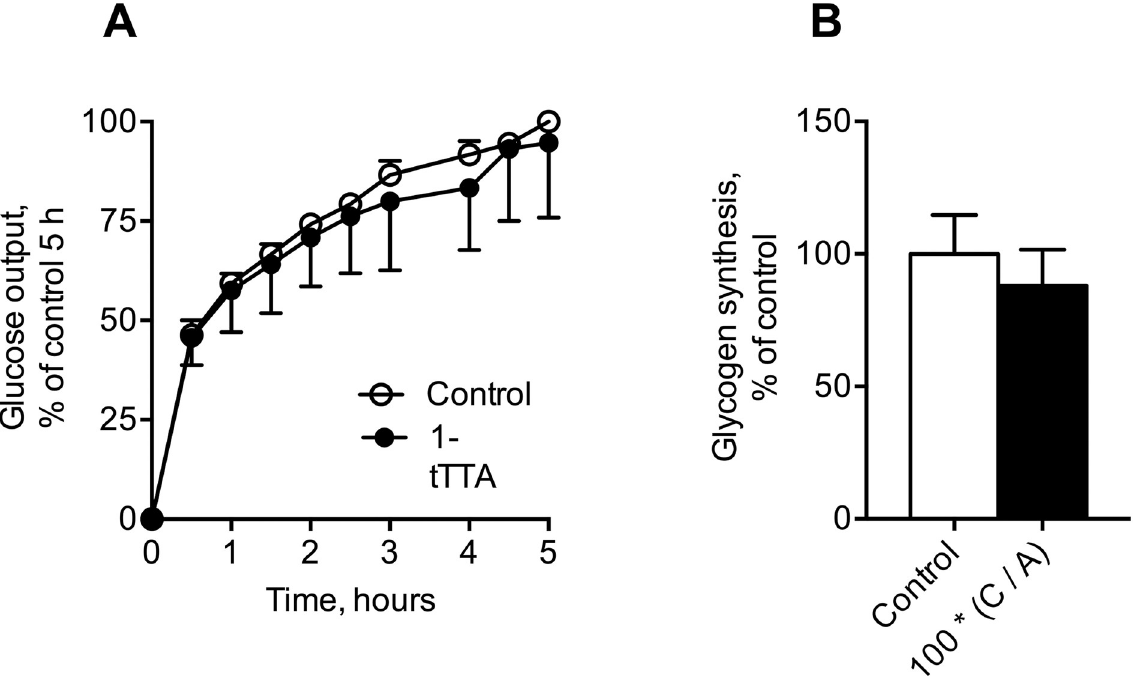
Fig 6. Effects 1-triple TTA (1-tTTA) on glucose output (a) and glycogen synthesis (b) in Huh7 cells. Huh7 cells were treated with vehicle (control) or 10 μ M 1-tTTA for 48 h. Glucose output and glycogen synthesis were measured as described in Materials and Methods. All values shown are means with standard deviation (n =